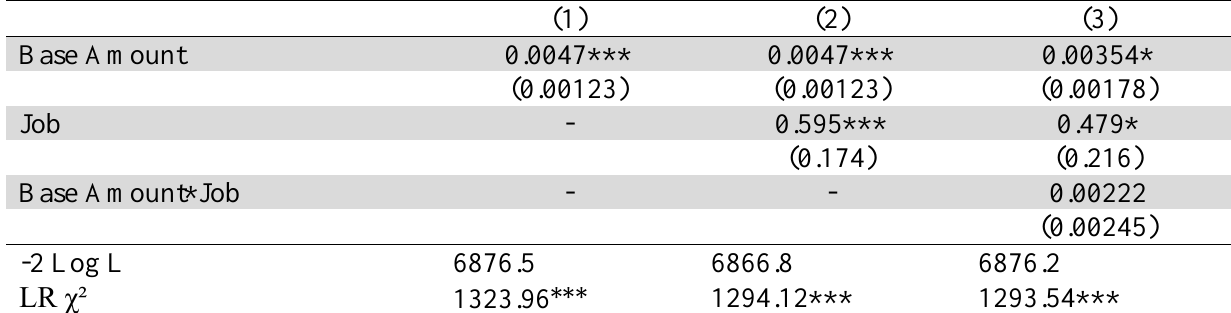
Repeated measures regressions of payment option